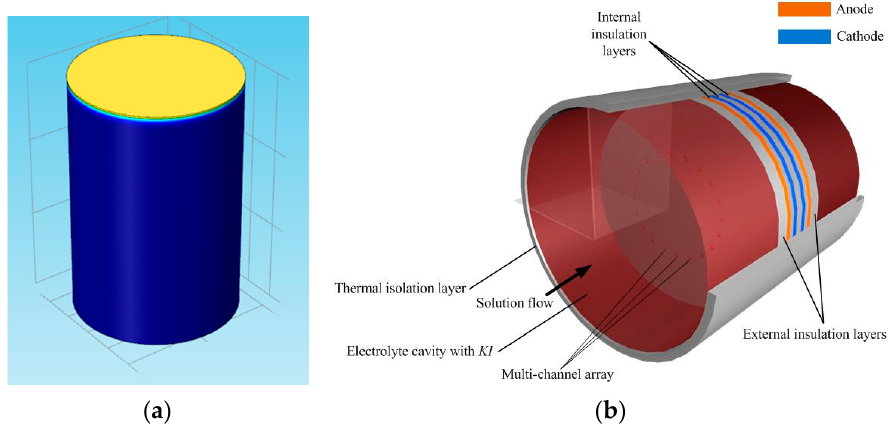
Figure 4. The structure of the reaction cavity ( a ) and the elastic membranes in the numerical simulation and the structure inside the reaction cavity ( b ).